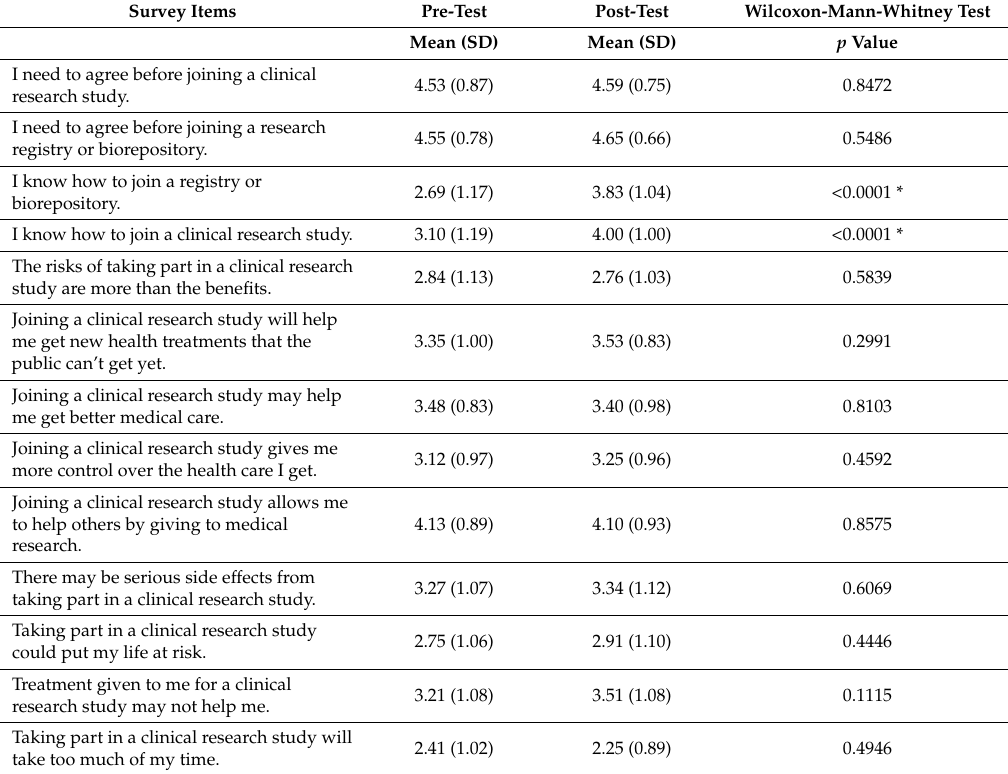
Table 4. Knowledge, perceptions and willingness to participate in clinical studies and biorepositories: Results of Wilcoxon–Mann–Whitney